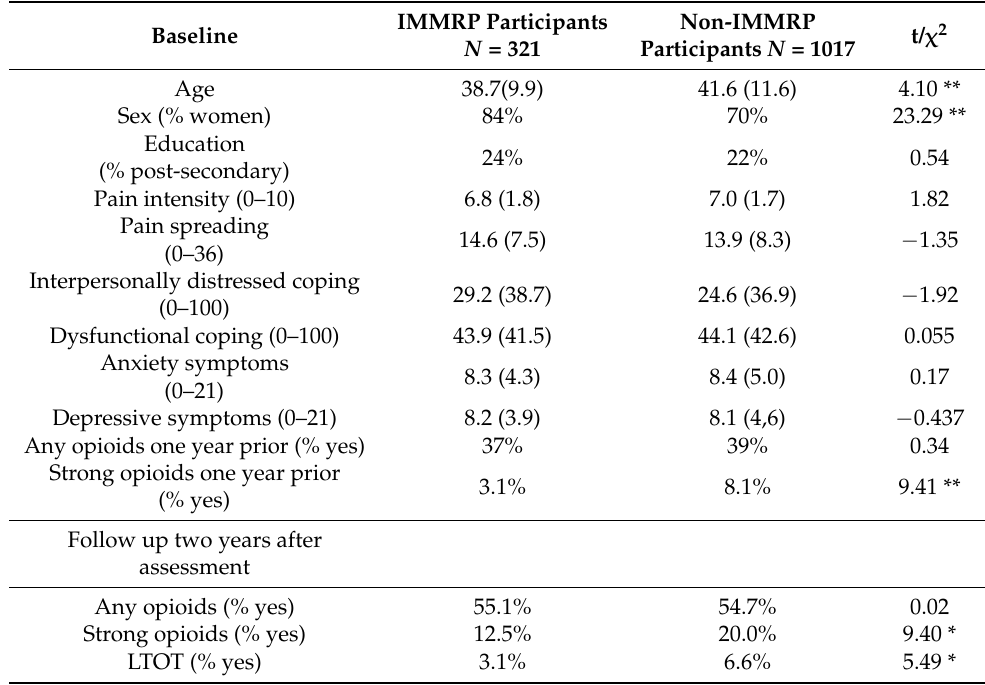
Table 2. Characteristics of the two